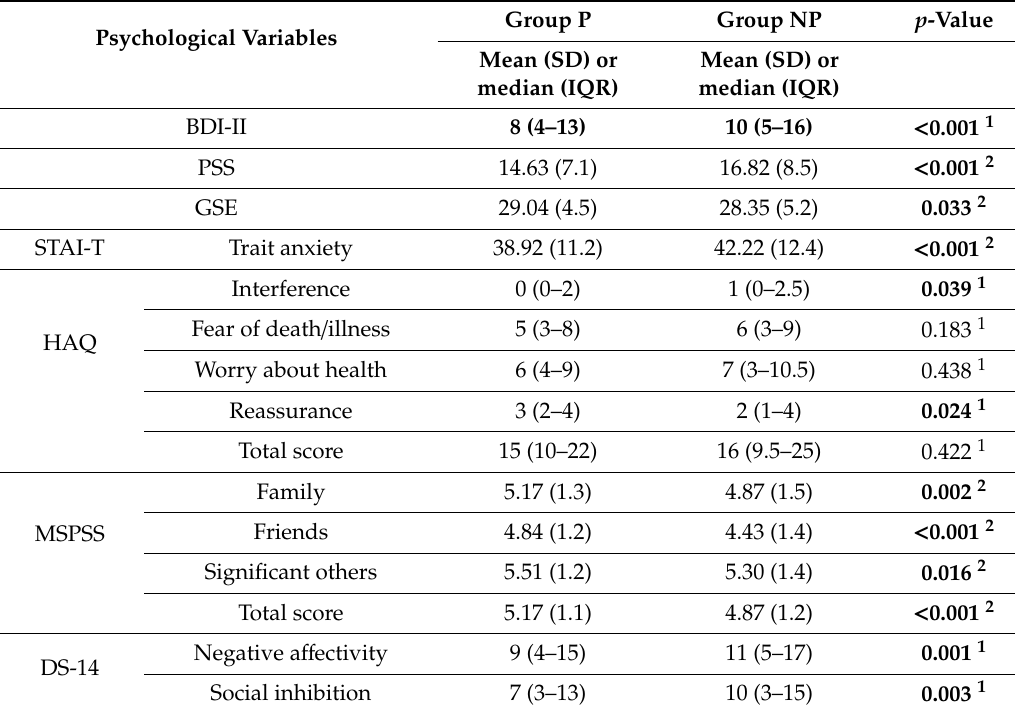
Table 3. Psychological